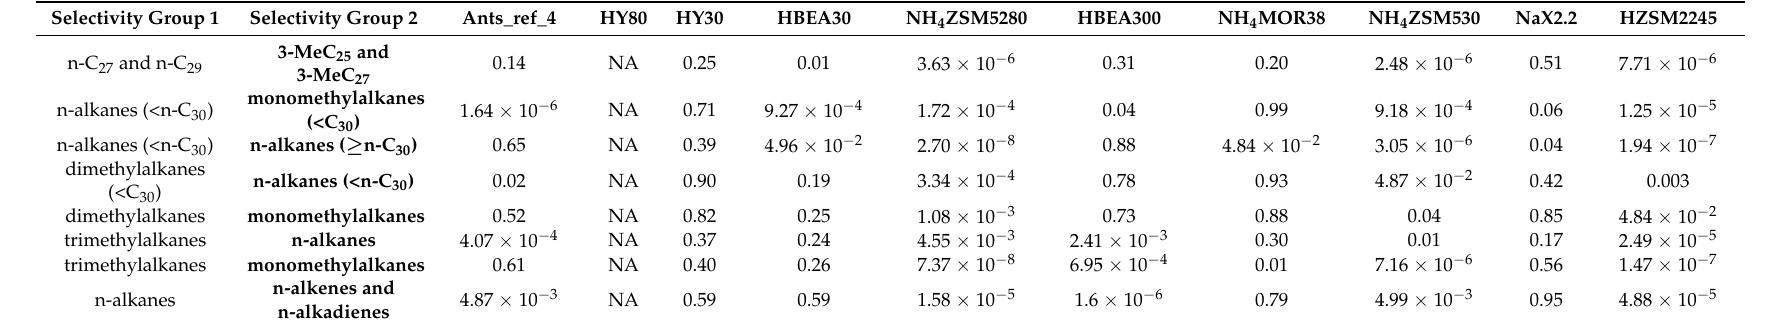
Table A3. Results of the posthoc tests on the Aitchison transformed data to assess the selectivity of the zeolites between two groups of compounds (Selectivity Group 1 and Selectivity Group 2). The p -values are provided from which the significance ( p < 0.05) can be determined. Column HY80 served as the reference sample, so the p-values are not applicable (NA) for this